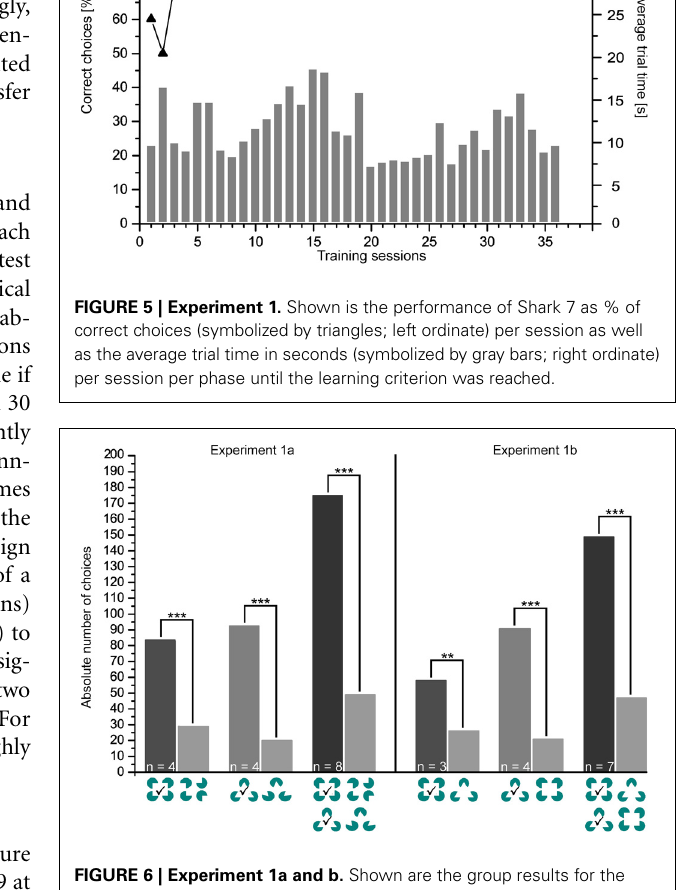
FIGURE 6 | Experiment 1a and b. Shown are the group results for the transfer test trials. p > 0 . 05 not significant, p ≤ 0 . 01 significant ( ∗∗ ), p ≤ 0 . 001 significant ( ∗∗∗ ). The correct choice is marked by a